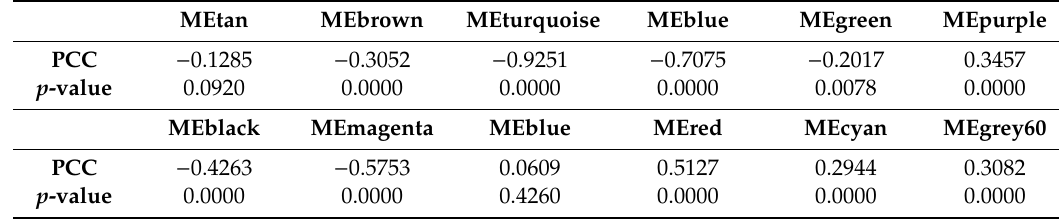
Table 2. The PCC between each module and cancer after pruning.